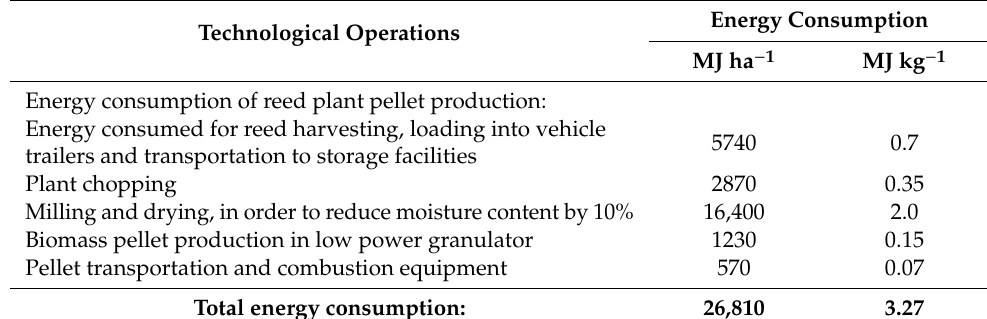
Table 5. The energy consumption of reed pellet production (yield of plant biomass 8.2 t ha − 1 , moisture content